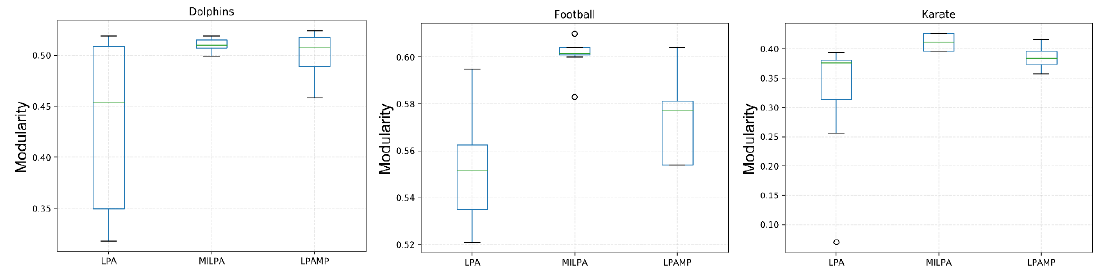
Figure 5. The modularity distribution of twenty community partitions of three networks by LPA, MILPA and LPAMP.